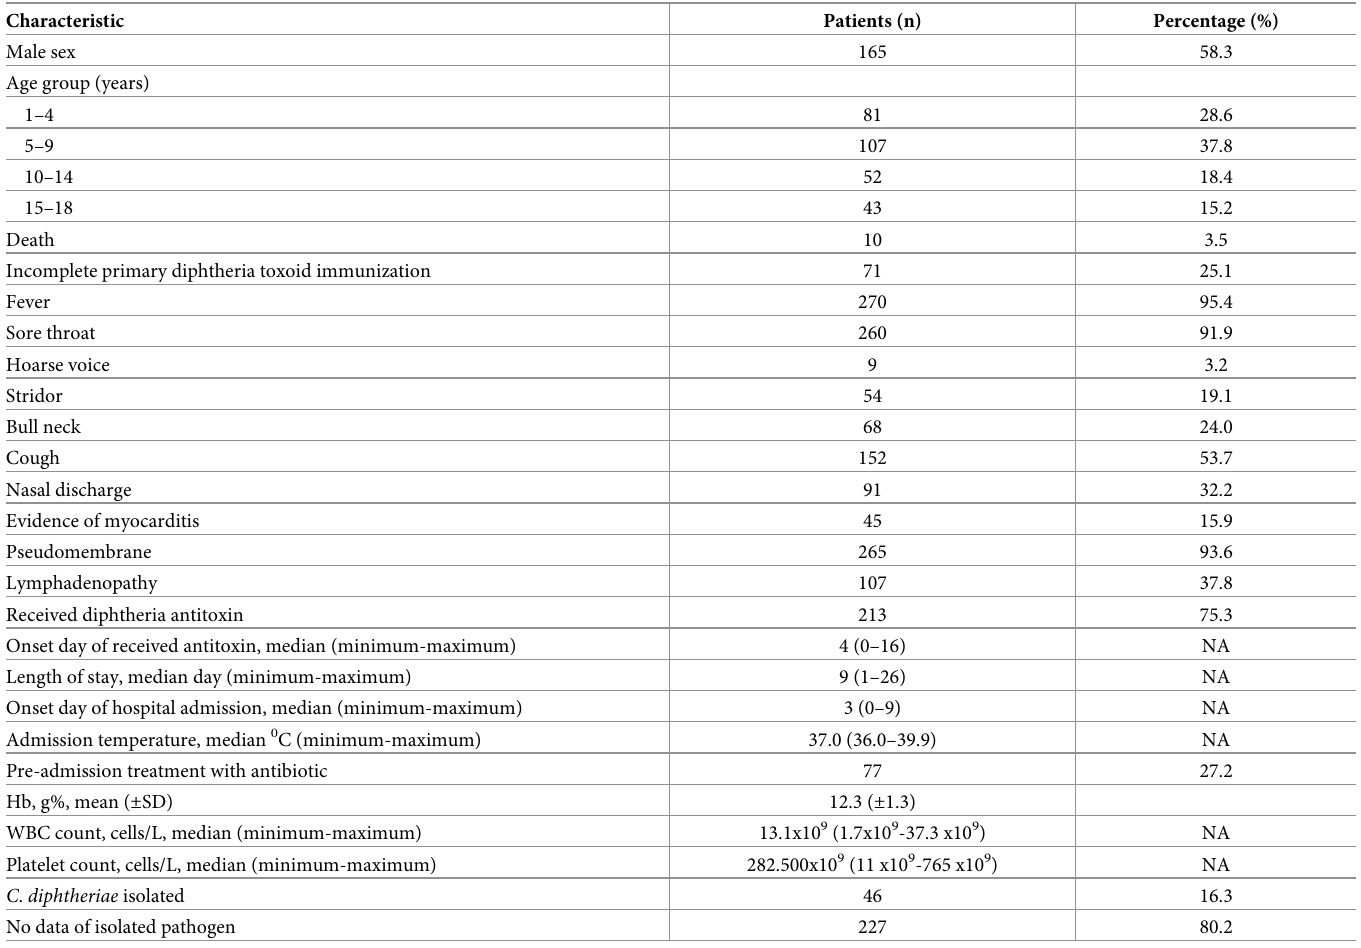
Table 2. Characteristics of research subjects (n =